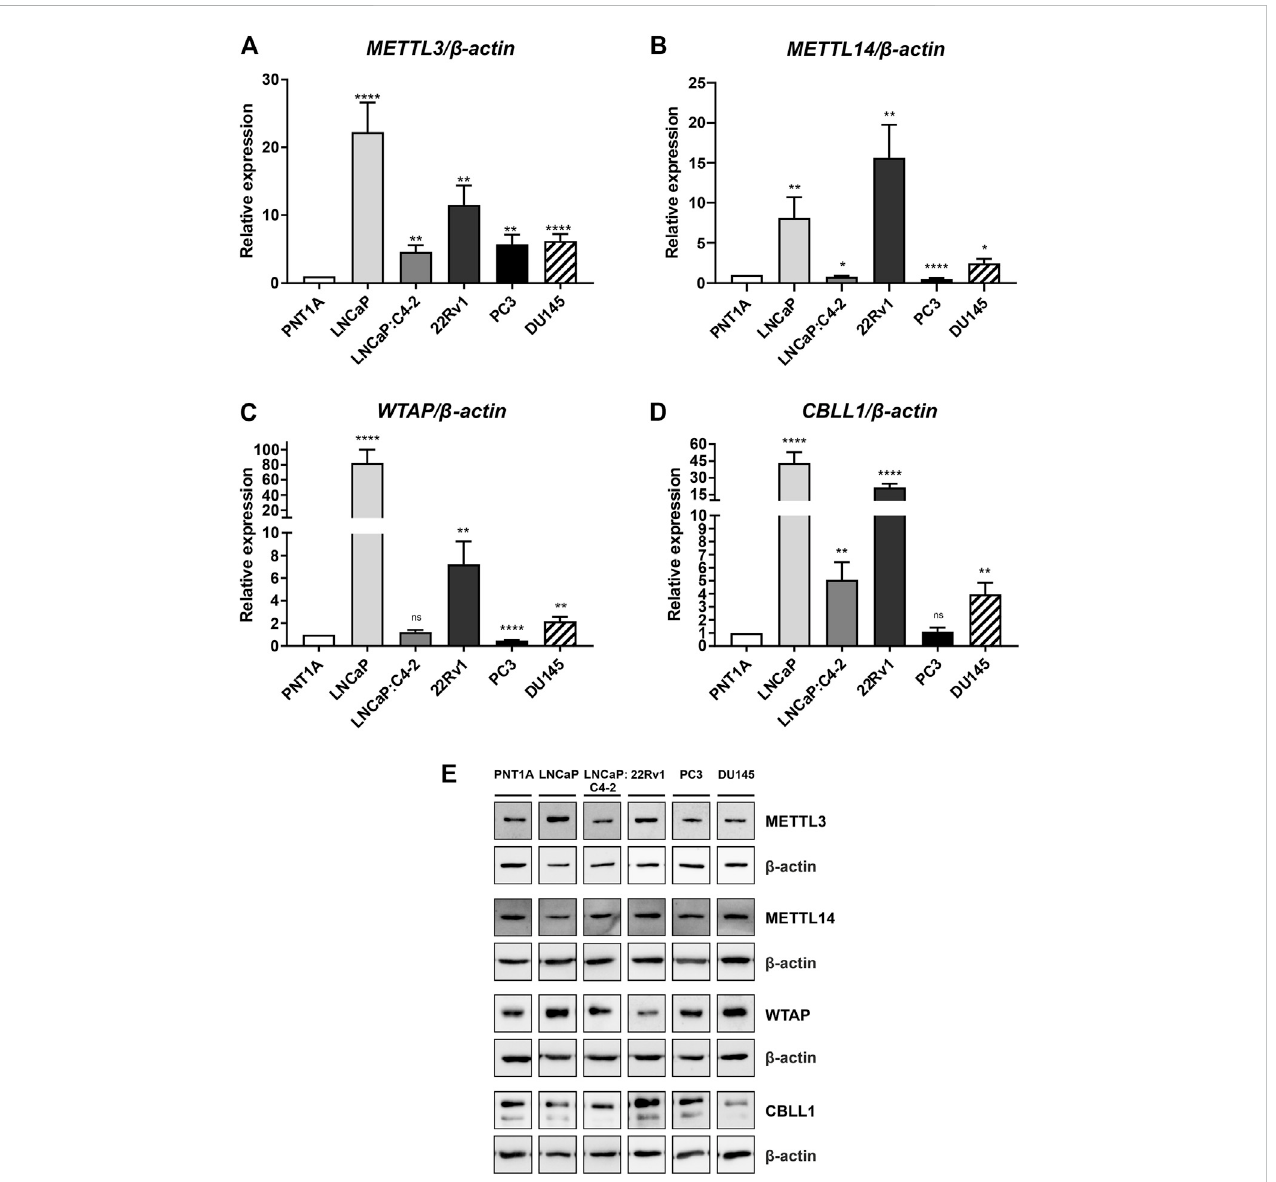
FIGURE 4 METTL3, METTL14, WTAP and CBLL1 expression in non-malignant and prostate cancer cell lines; mRNA expression analysed by qRT-PCR relative to β - actin (A – D) and protein expression analysed using western blot (E) . METTL3 protein expression as previously reported in Haigh et al. (2022). * p ≤ .05, ** p